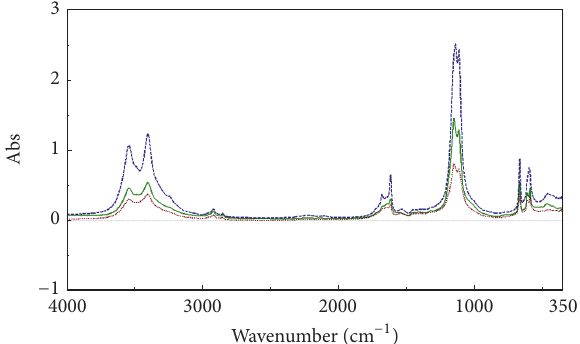
Figure 3: FTIR spectrum of red border (solid line) and of blue (dashed line) and of yellow (dot line) painting materials.